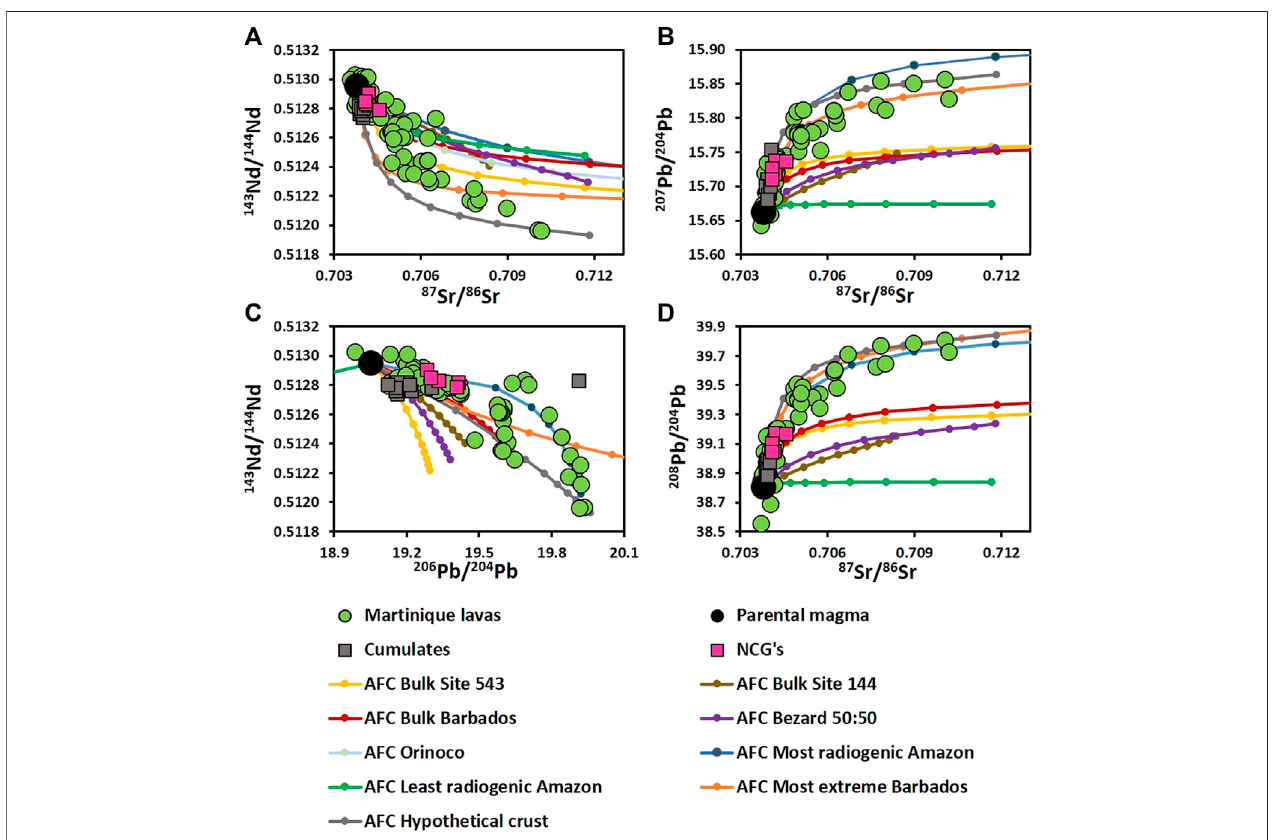
FIGURE11|(A) 87 Sr/ 86 Srvs. 143 Nd/ 144 Nd, (B) 87 Sr/ 86 Srvs. 207 Pb/ 204 Pb, (C) 206 Pb/ 204 Pbvs. 143 Nd/ 144 Ndand (D) 87 Sr/ 86 Srvs. 208 Pb/ 204 Pb,forMartiniquelavas and plutonic xenoliths (this study). Data sources as per Table 3 and Figure 8 . For all data points, uncertainty (2 SE) is smaller than symbol size. Each colored curve corresponds to an AFCmodel using adifferent crustal end memberfrom Table 3 as theassimilant composition(see legend). Each point alongthe curves represents an increment of 10% fractional crystallization, up to a maximum of 90%. Details of AFC model calculations are given in Supplementary File S3 .